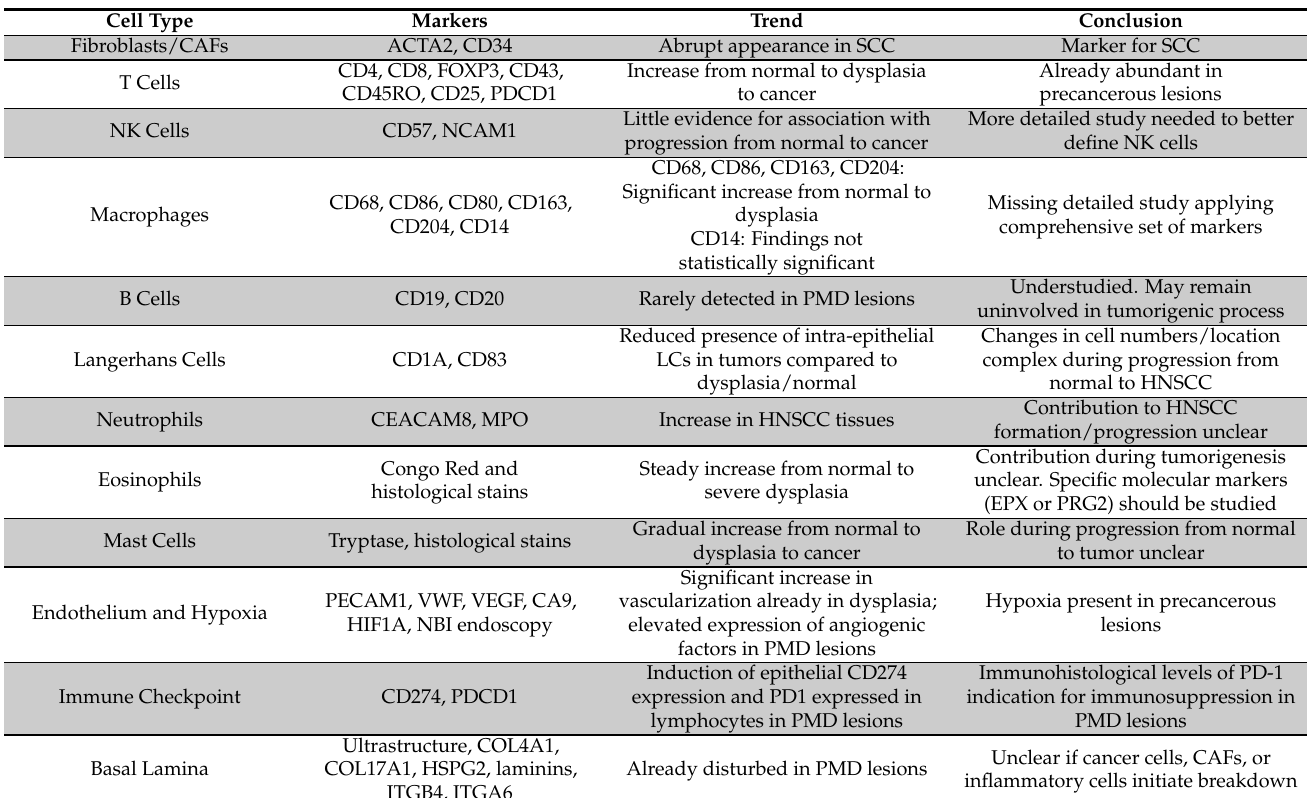
Table 1. Summary of the findings and relevance of the different stromal components in the progres- sion from normal to